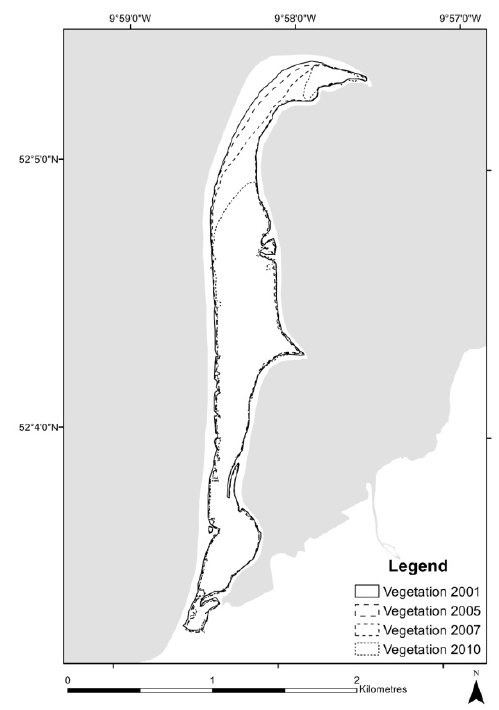
Figure 3. Vegetation alignment of Rossbeigh.